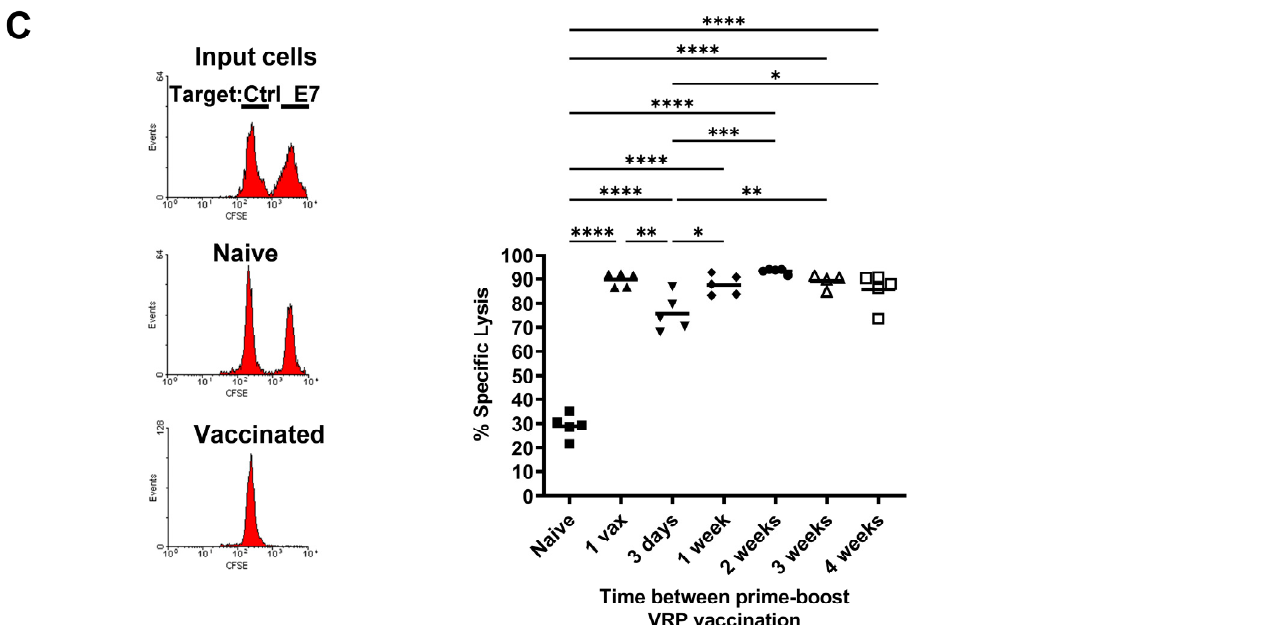
Figure 2. Ex vivo analysis of T-cell response after different prime-boost intervals. C57BL/6 mice ( n = 5/group per experiment) were immunized i.m. with 1 × 10 7 IU HPV16 E7E6 VRP according to the vaccination schedule in Figure 1. ( A ) HPV16 E7-specific IFN γ secretion by ELISpot assay. Shown are the number of spot-forming cells (SFC) per million splenocytes for each mouse from three independent experiments with the mean indicated by the horizontal bar. Mean SFC from all vaccinated mice were significantly increased compared to naïve mice (range of p < 0.05 to p < 0.0001, one-way ANOVA). ( B ) Splenocytes were tested for binding of H2-D b MHC tetramers loaded with HPV16 E7 (49–57) peptide. Shown is the percentage of E7 tetramer-binding CD8 + T cells for each group of mice from three independent experiments with the mean indicated by the horizontal bar. Mice vaccinated at 4 wk, 3 wk, 2 wk, and 1 wk prime-boost exhibited a greater mean number of E7 tetramer positive CD8 + T cells compared to naïve mice (range of p < 0.01 to p < 0.0001). ( C ) In vivo cytotoxicity assay. Naïve C57Bl/6 splenocytes were loaded with E7 (49–57) peptide or irrelevant control D b -binding peptide, then labeled with a high dose (E7peptide-loaded) or low dose (control peptide- loaded) of CFSE. Shown are representative histogram plots of input labeled cell populations and CFSE populations in a naïve or vaccinated mouse. Calculated E7-specific cytotoxicity is shown for all groups. Specific lysis in all vaccinated groups is significantly different from naïve mice ( p < 0.0001). * p < 0.05, ** p < 0.01, *** p < 0.001, **** p < 0.0001 (One-way ANOVA, Tukey’s post-test). All significant pairwise comparisons are indicated in the figure. All other pairwise comparisons were not